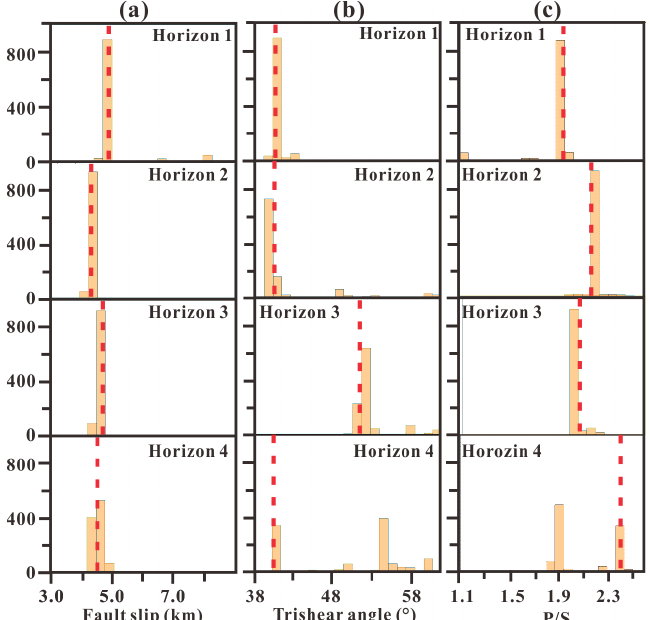
Figure 12. The inversion results of horizons 1–4 in Figure 9b show the distributions of the ( a ) Fault slip, ( b ) Trishear angle, and ( c ) P/S ratio. Red dashed lines indicate the values of best-fit parameters acquired from inverse modeling. See the text for a detailed analysis.